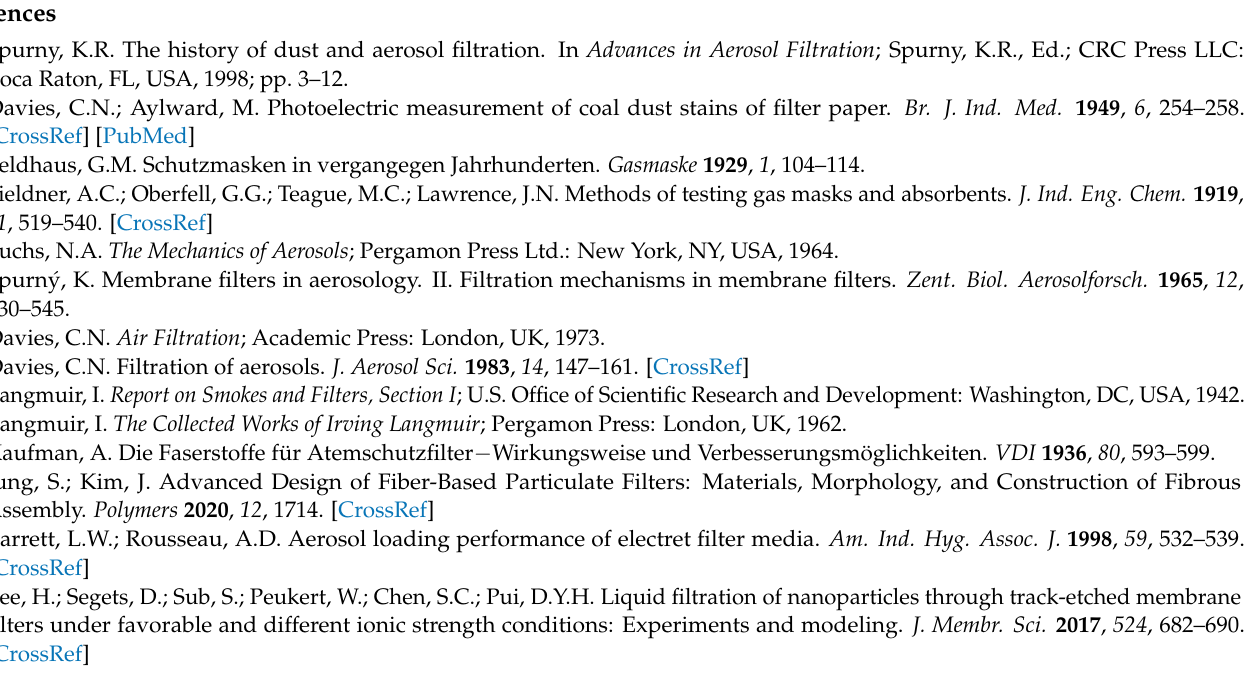
Table S2. Mass concentration under uncontrolled and controlled temperature and humidity environ- ments; Table S3. Major infrared bands of the principal polymorphs in crystalline silica; Figure S1. Historical examples of mine safety equipment; Figure S2. Coal mine dust personal sampler unit (CMDPSU); Figure S3. Personal dust monitor (PDM3700); Figure S4. Scanning electron microscopic images for different filters; Figure S5. Penetration as a function of particle diameter for different filters; Figure S6. Pressure drop as a function of sampling flow rate for silver membrane filters; Figure S7. Absorption of blank membrane filters; Figure S8. FTIR spectra for blank Teflon-coated glass-fiber